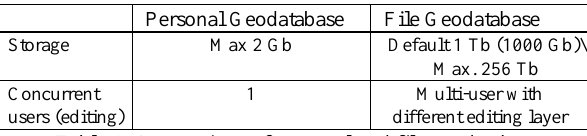
Table 1. Comparison of personal and file geodatabase